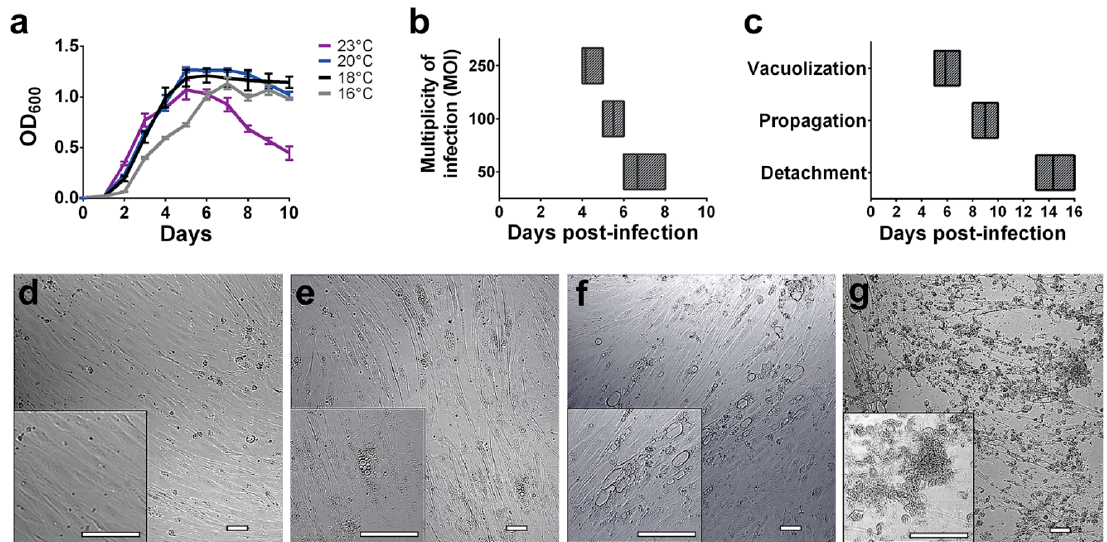
Figure 1. P. salmonis growth and infection progression in salmon macrophage-like cells. ( a ) Growth curves P. salmonis at different temperatures. ( b ) Day of appearance of CPE in SHK-1 cells using different MOI. ( c ) Day of occurrence of the different infection stages using MOI = 100. Results in ( a – c ) are shown as the average of three independent assays with its correspondent standard deviation. ( d – g ) Representative bright-field micrographs of P. salmonis infected SHK-1 cultures. ( d ) Uninfected SHK-1 cells (control). ( e ) Vacuolization stage, cells showed small and dispersed intracellular vacuoles. ( f ) Propagation stage, characterized by the presence of large vacuoles in groups of cells. ( g ) Detachment in all fields. Images taken with 100 × optical magnification and 300 × digital magnification (inset), bar = 100 µ